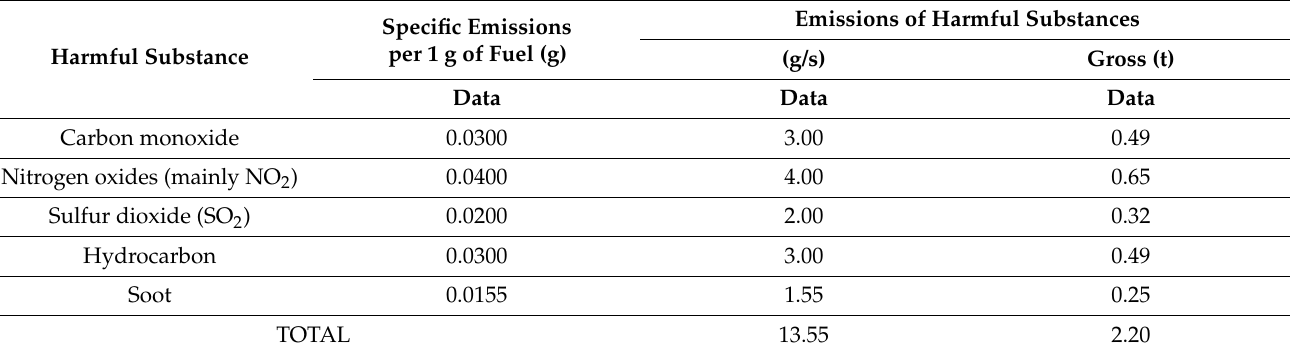
Table 1. Emissions of the equipment during the construction and the treatment of the